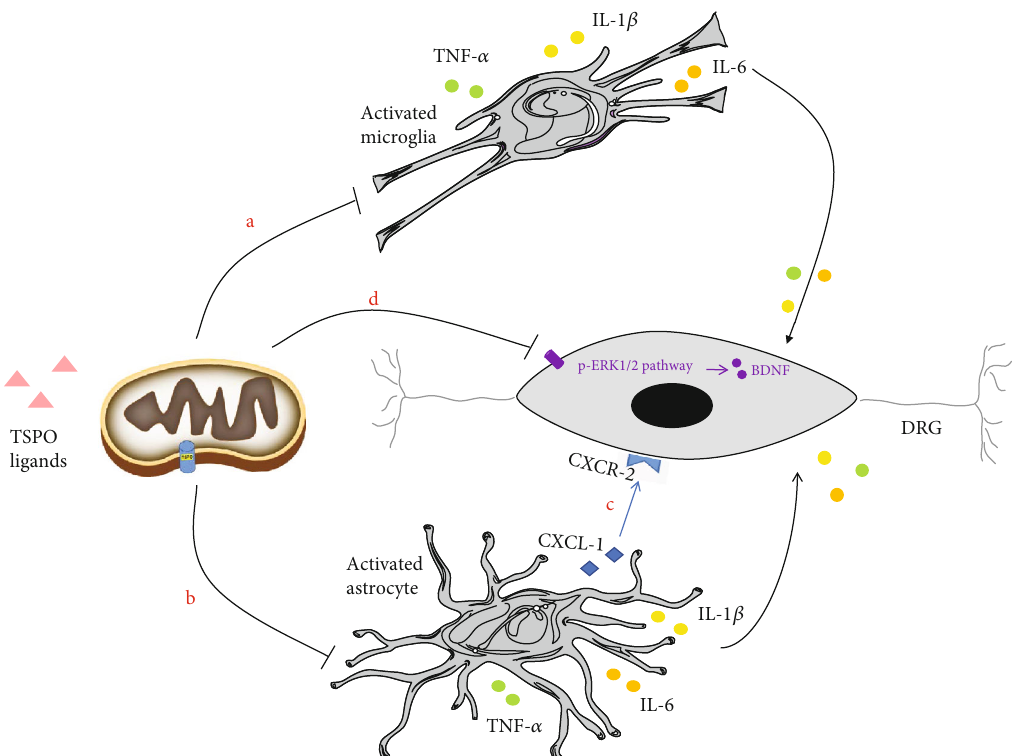
Figure 2: Molecular mechanisms by which TSPO and its ligands inhibit chronic pain induced by peripheral nerve injury. (a, b) TSPO and its ligands inhibit microglia and astrocytes to secrete in fl ammatory factors TNF- α , IL-1 β , and IL-6. These in fl ammatory factors can cause neuroin fl ammation leading to chronic pain. (c) TSPO and its ligands inhibit CXCL1-CXCR2-dependent astrocyte-to-neuron signaling and central sensitization. (d) TSPO and its ligands inhibit the expression of the p-ERK1/2 signaling pathway and its downstream BDNF in DRG. BDNF is synthesized in DRG causing chronic pain by regulating neurotransmitter production. TNF- α : tumor necrosis factor- α ; IL-1 β : interleukin-1 β ; IL-6: interleukin-6; CXCL1: chemokine CXC motif ligand 1; CXCR2: chemokine CXC motif receptor 2; p-ERK1/2: phospho-extracellular signal-regulated kinase 1/2; BDNF: brain-derived neurotrophic factor; DRG: dorsal root